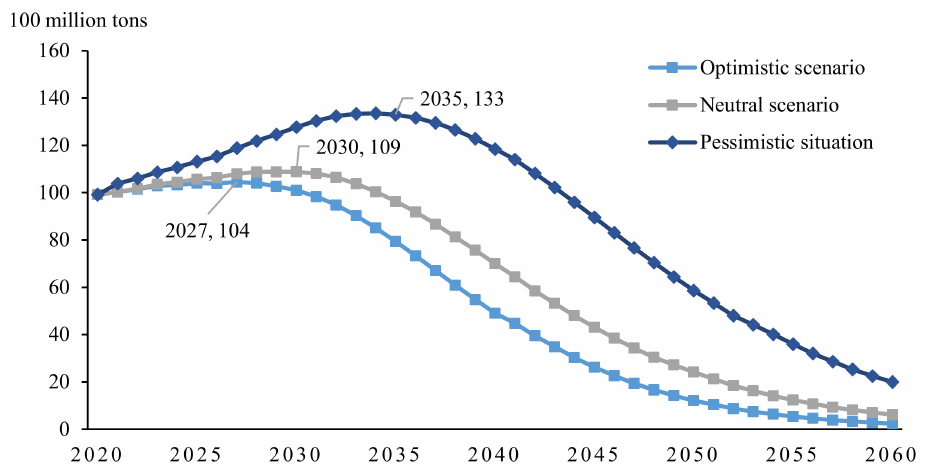
Figure 13. Carbon emission curve of different